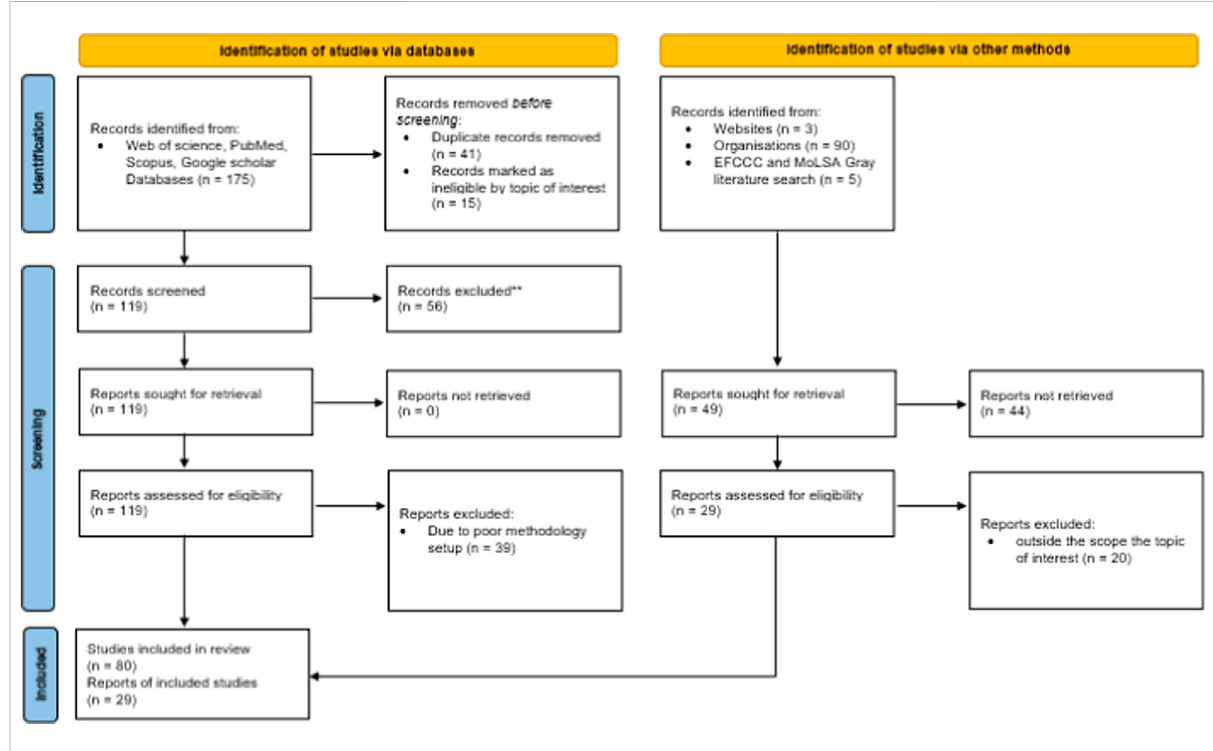
FIGURE 8 PRISMA 2020 fl ow diagram for the included studies in the systematic